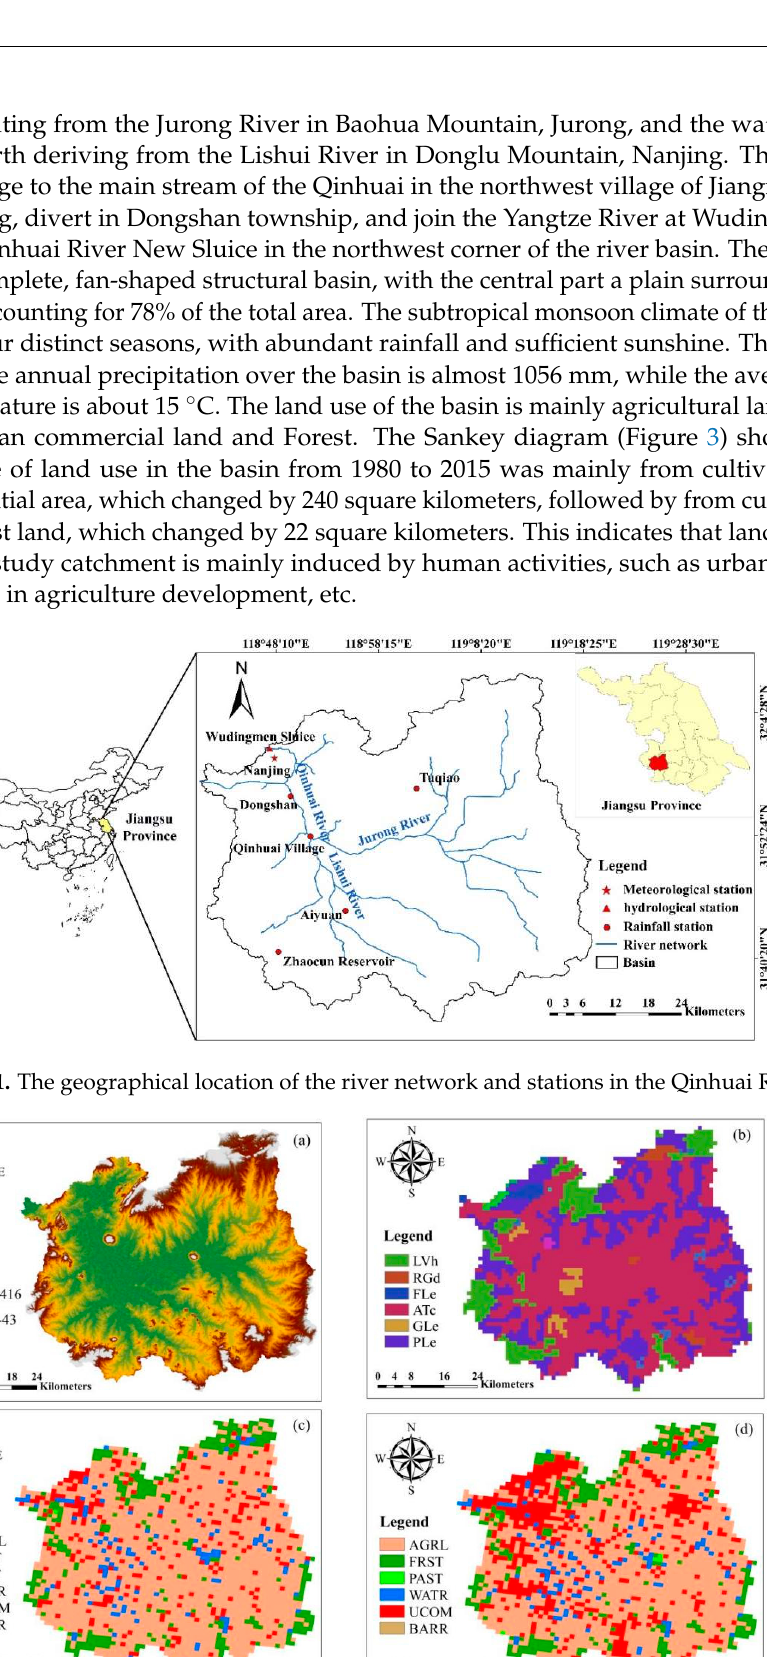
Figure 3. The land use changes in the Qinhuai River Basin from 1980 to 2015. 2.2. SWAT Model 2.2.1. Principle and Development of Model The Soil and Water Assessment Tool (SWAT) [42] is a public-domain-distributed hy- drological model developed by the Agricultural Research Service of the United States De- partment of Agriculture (USDA-ARS) in 1994. It is a physics-based model that combines the Simulator for Water Resources in Rural Basins (SWRRB) model and the Routing Out- puts to Outlet (ROTO) model organically [43]. Since its successful development, the model has been improved several times in more than 30 years and has made great progress in the research depth and application fields. This study was carried out by using the model version of SWAT2012, which is a version with more accurate simulation results by con- stantly adding new modules, modifying calculation methods, and increasing the scope of application [44]. It takes the day as the time step, simulates the continuous time series, and uses the discretization method to describe the spatial differences of hydrological ele- ments and other parameters in the basin. The hydrological process simulated by the SWAT model can be divided into the runoff generation and overland flow concentration phase and the river confluence phase. In the model, the basin is first divided into multiple